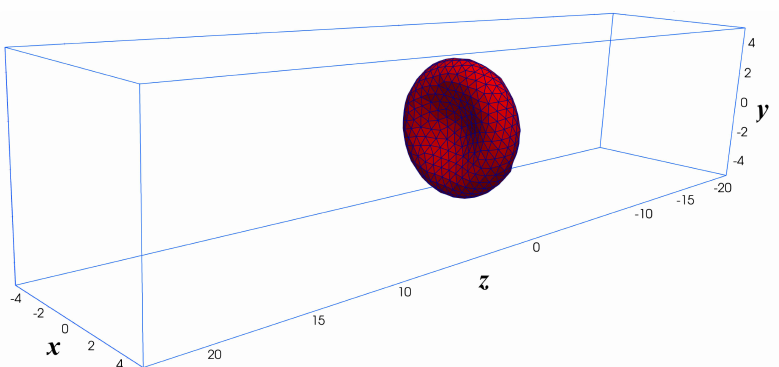
Figure 6. Computational setup for the Fluid-Structure Interaction simulation of a single RBC in uniform flow. The computational domain is a structured mesh of size 10 µ m × 10 µ m × 45 µ m. The uniform flow (no shear) is applied at the ( x - y ) plane of z = − 22.5 µ m. The Neumman boundary condition is applied at the outlet. Symmetry (slip) boundary condition is applied on the other sides. The RBC is initially placed at the center of the computational domain z = 0.